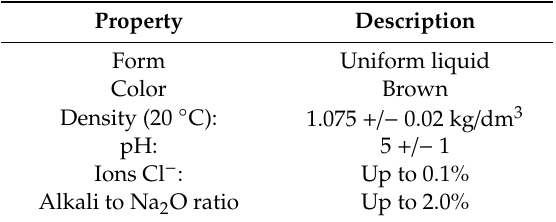
Table 3. Basic properties of plasticizing admixture.